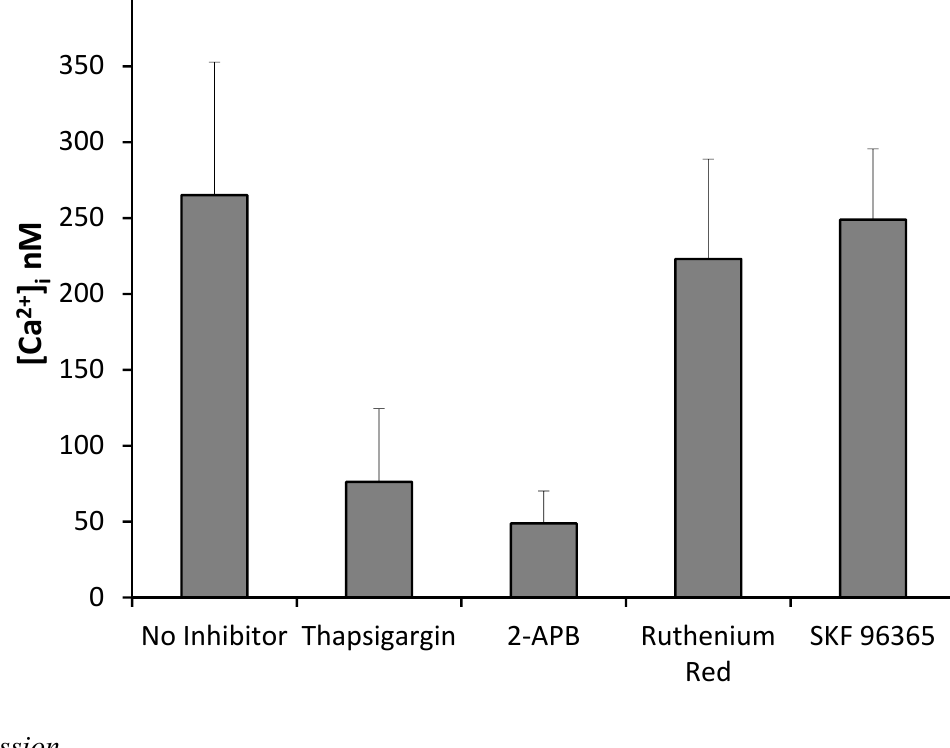
Figure 12. Resveratrol causes the release of calcium from the endoplasmic reticulum of activated endothelial cells. Cells were loaded with fura-2 AM, and live imaging was performed with a BD Pathway microscope. Cells were pre-incubated with different pharmacological agents or vehicle control and then treated with 100 µM